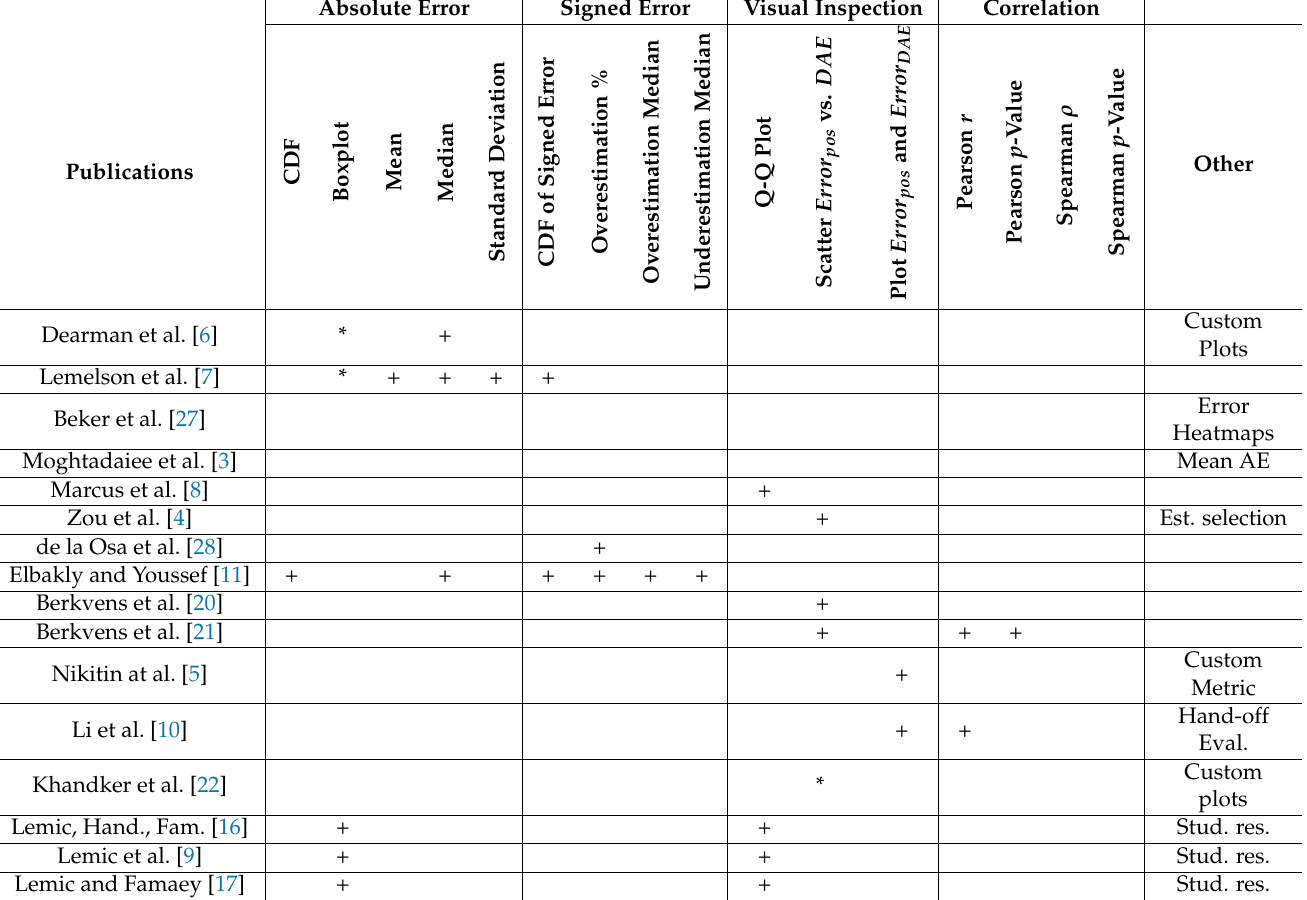
Table 2. Evaluation metrics and plots used by related works (the * indicates an adjustment of the metric or plot).